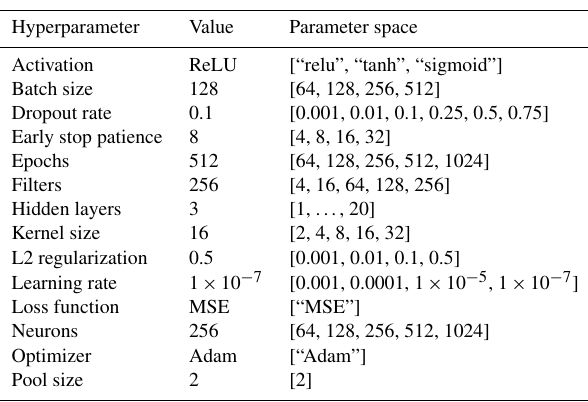
Table 5. DeepPrecip hyperparameters optimization